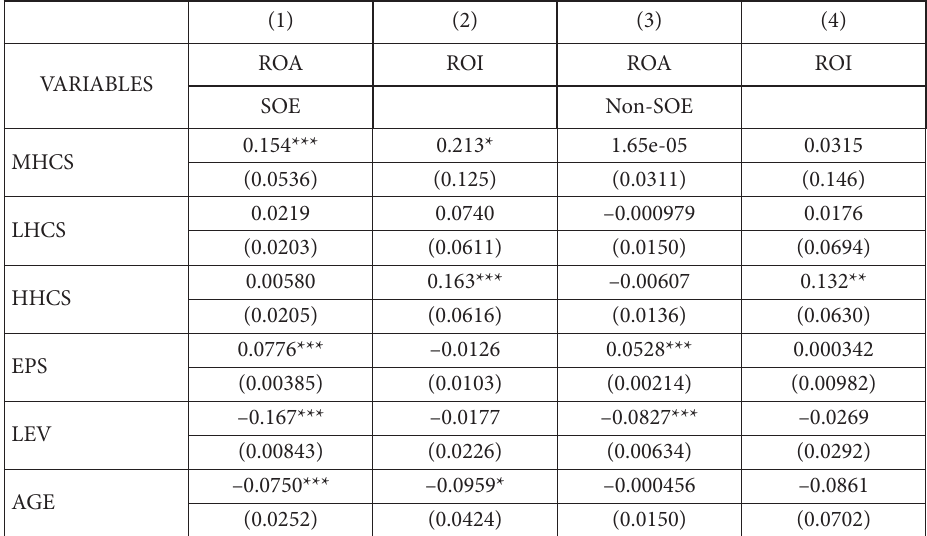
Table 3. 2sls instrumental regression (all types of hierarchical